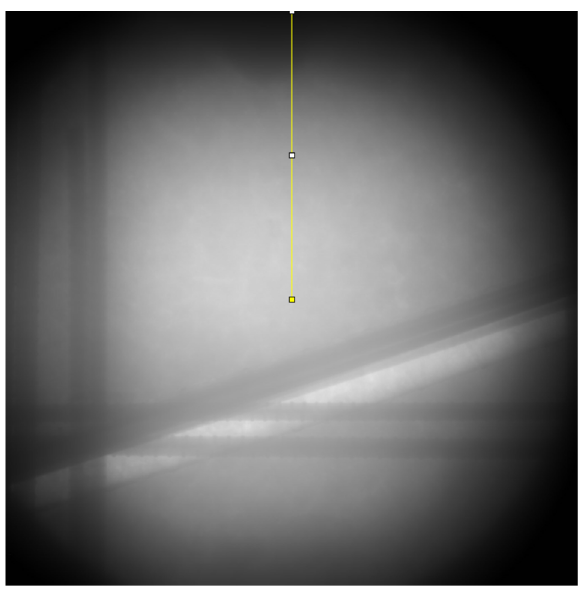
Figure 14. Typical X-ray image of circular shape at the FPD screen and intensity profile evaluating line.